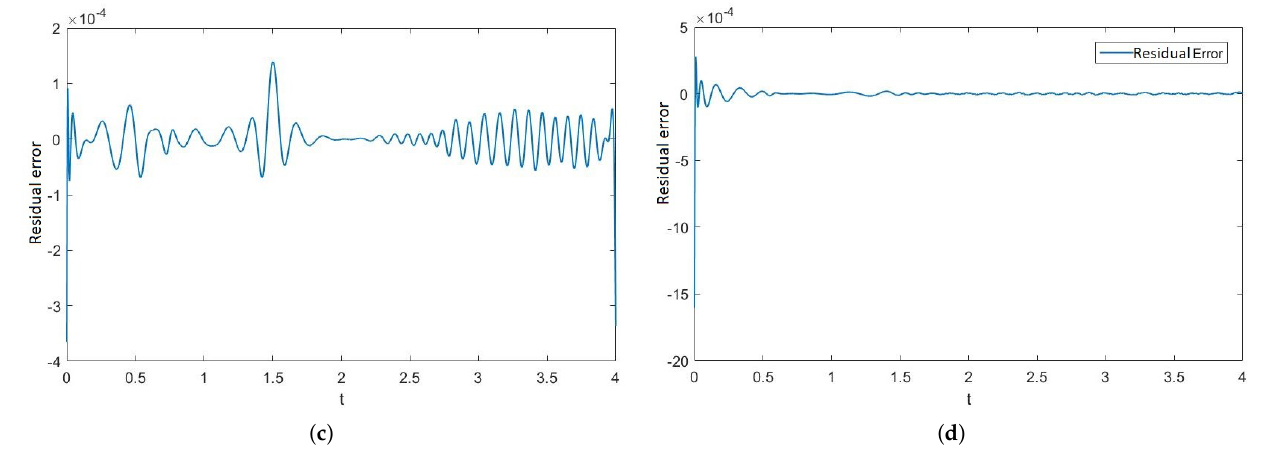
Figure 5. Graphical representation of F and the residual error graphs when rotation parameter K varies. ( a ) Graphical illustration of F when rotation parameter K varies. ( b ) Error in F when K = 0.1. ( c ) Error in F when K = 0.2. ( d ) Error in F when K = 0.3.